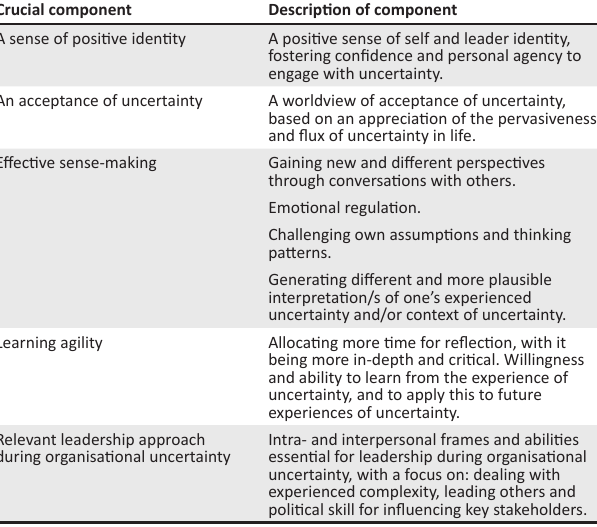
TABLE 6: Crucial components for developing a holistic capability for uncertainty. Crucial component Description of